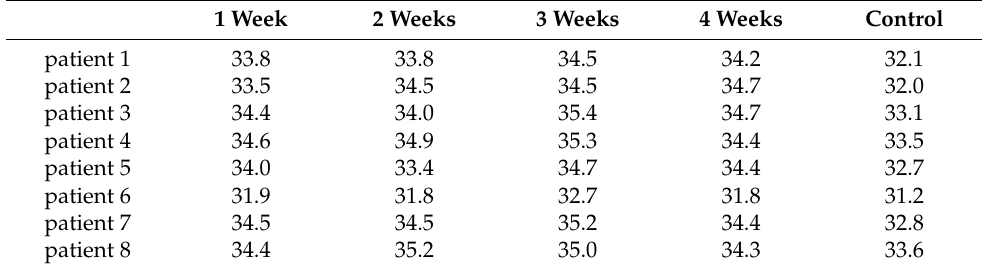
Table 1. The average temperature changes during radiotherapy in patients in the Planned Target Volume (PTV) area and control